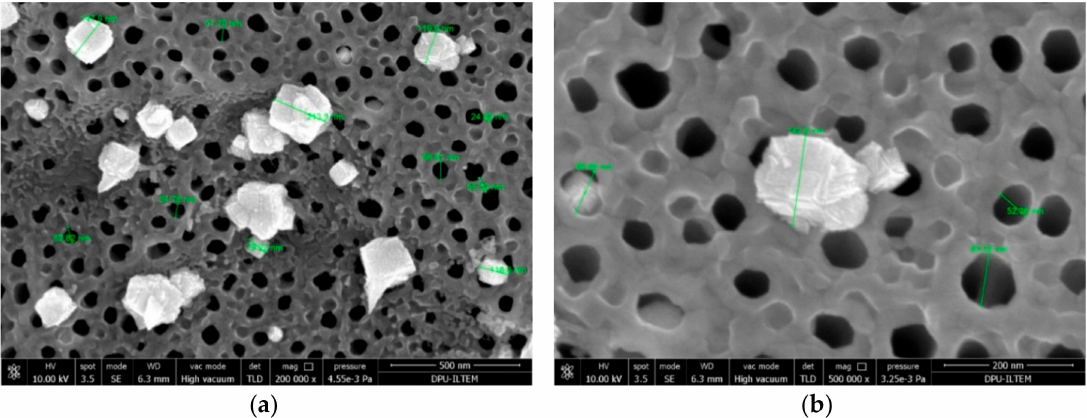
Figure 10. SEM images of Ti/TiO 2 NTEG-3h-500-Pt-25cycles photoanode at magnification: 200,000 × ( a ); and 500,000 × ( b